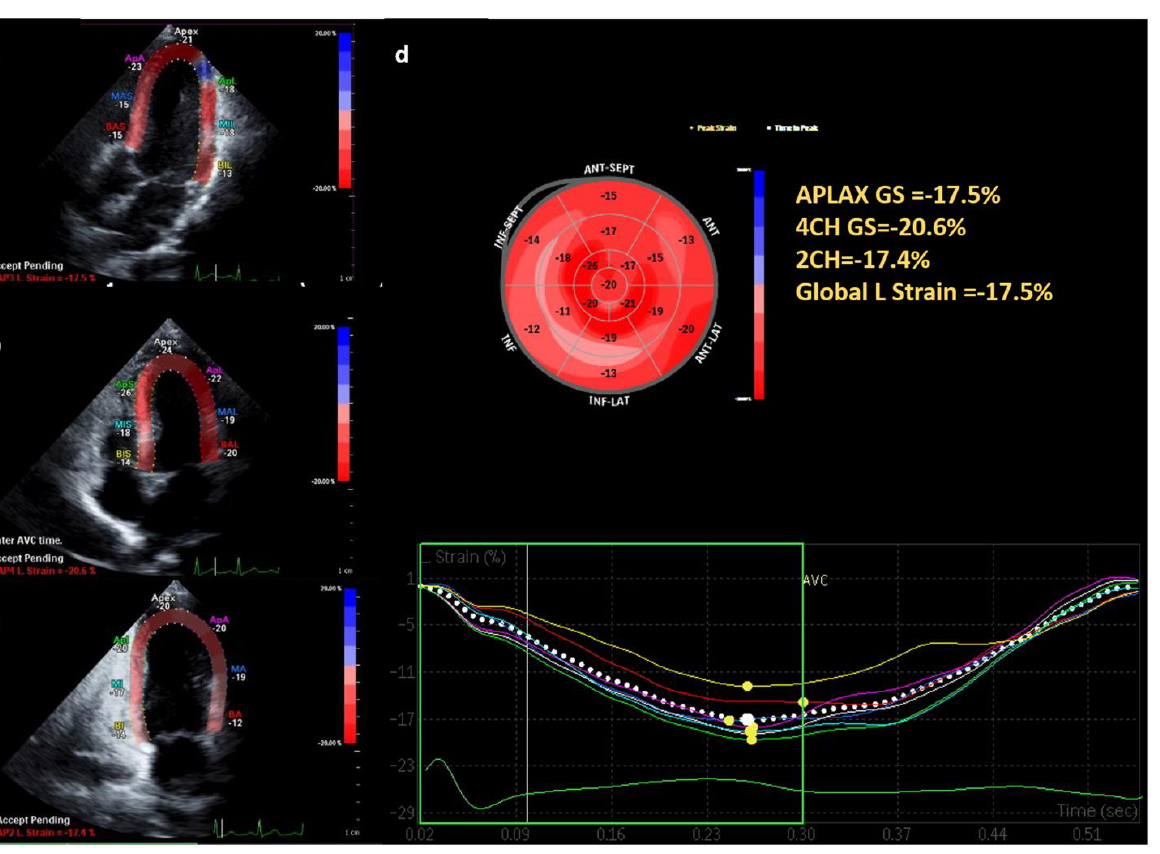
Figure 3. Left ventricular GLS assessment with two-dimensional speckle tracking echocardiography. The figure demonstrates analysis of left ventricular GLS from the three-chamber ( a ), four- chamber (4CH) ( b ) and two-chamber (2CH) ( c ) views. ( d ) Polar map with the regional values and the GLS value calculated from the 17 segments which is within the normal value.